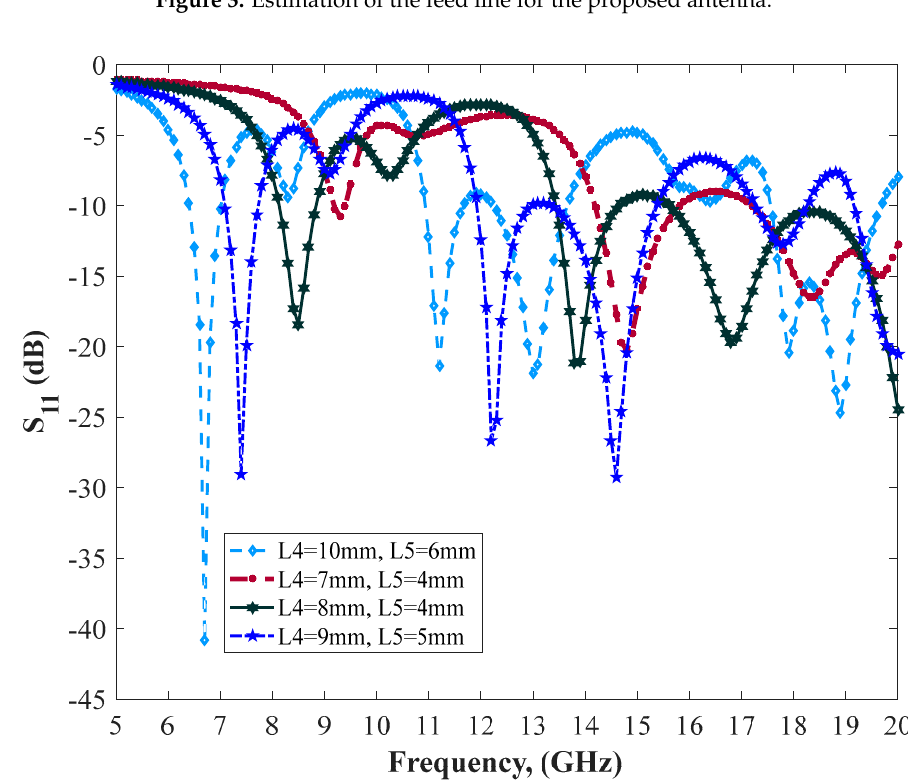
Figure 4. S11 curves for calculation of the best dimensions of the proposed patch antenna.